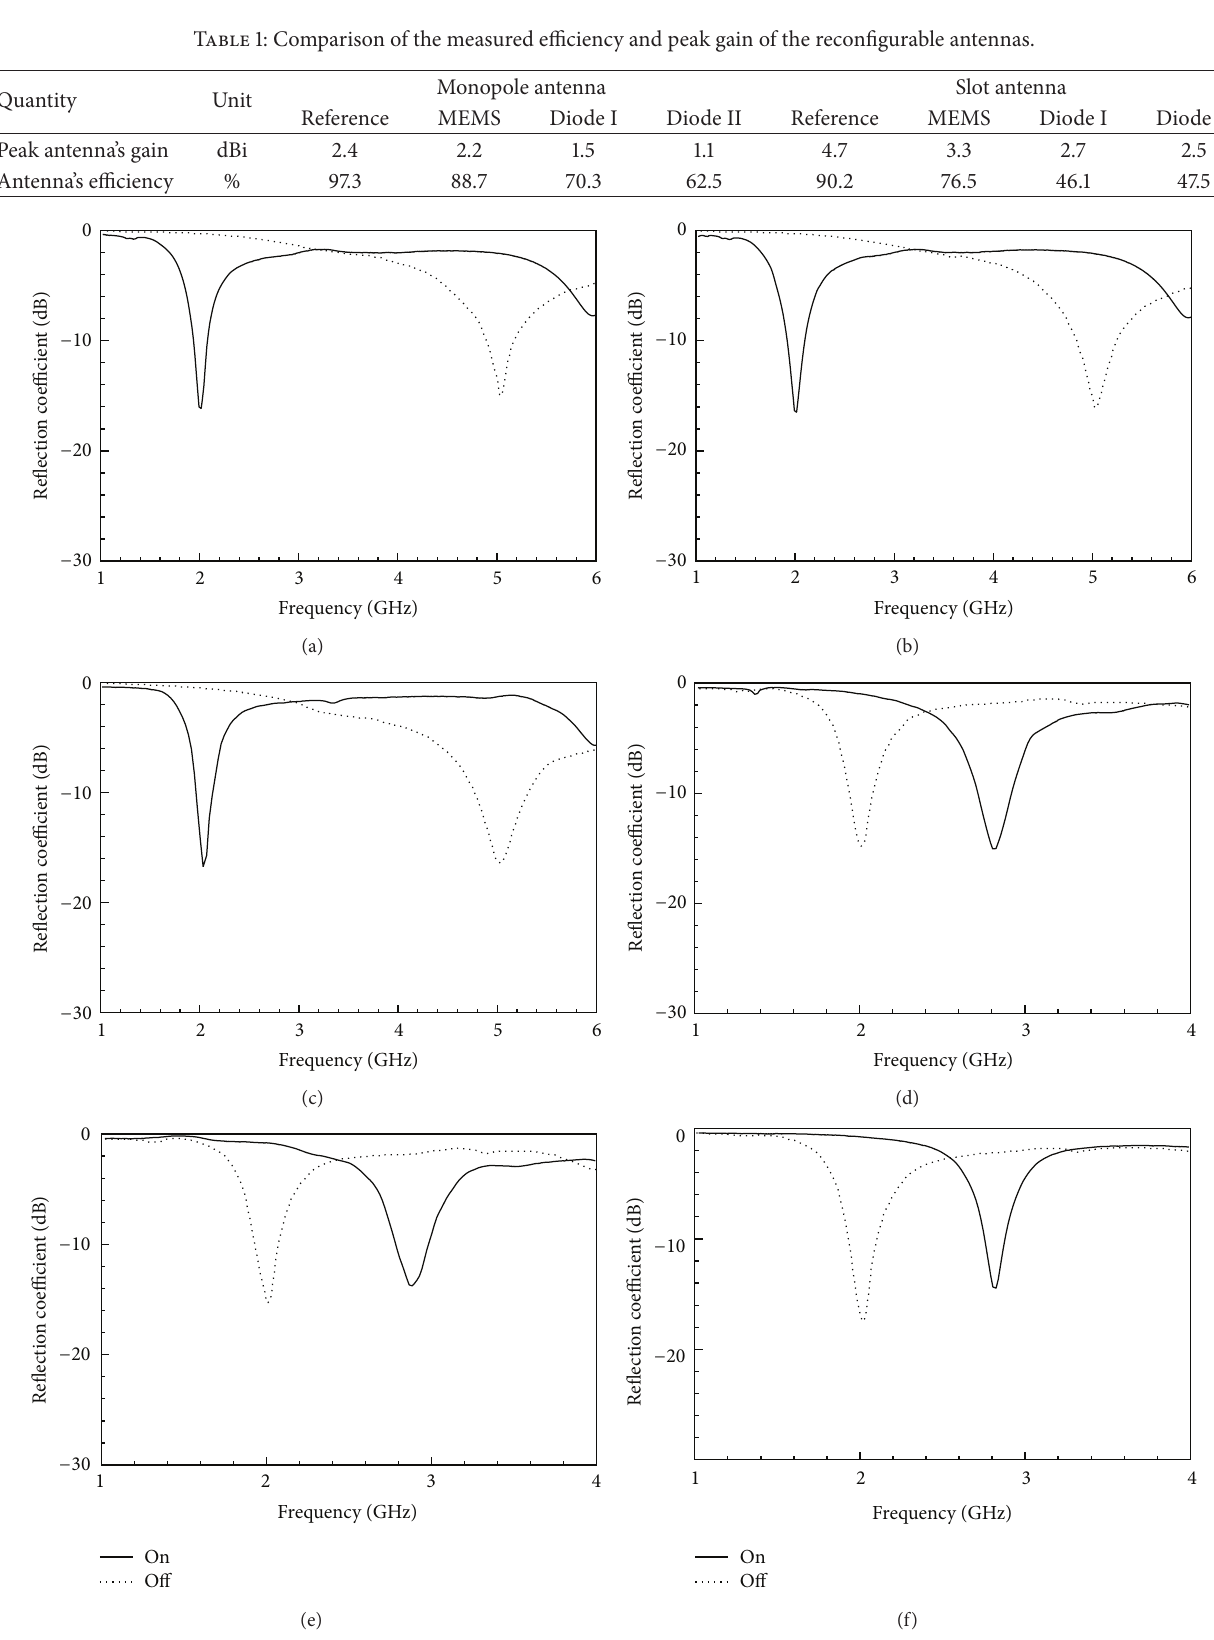
Figure 13: Measured reflection coefficients ( |𝑆 11 | ) of the proposed reconfigurable antennas; (a) the monopole with Diode I, (b) the monopole with Diode II, (c) the monopole with MEMS switch, (d) the slot with Diode I, (e) the slot with Diode II, and (f) the slot with MEMS